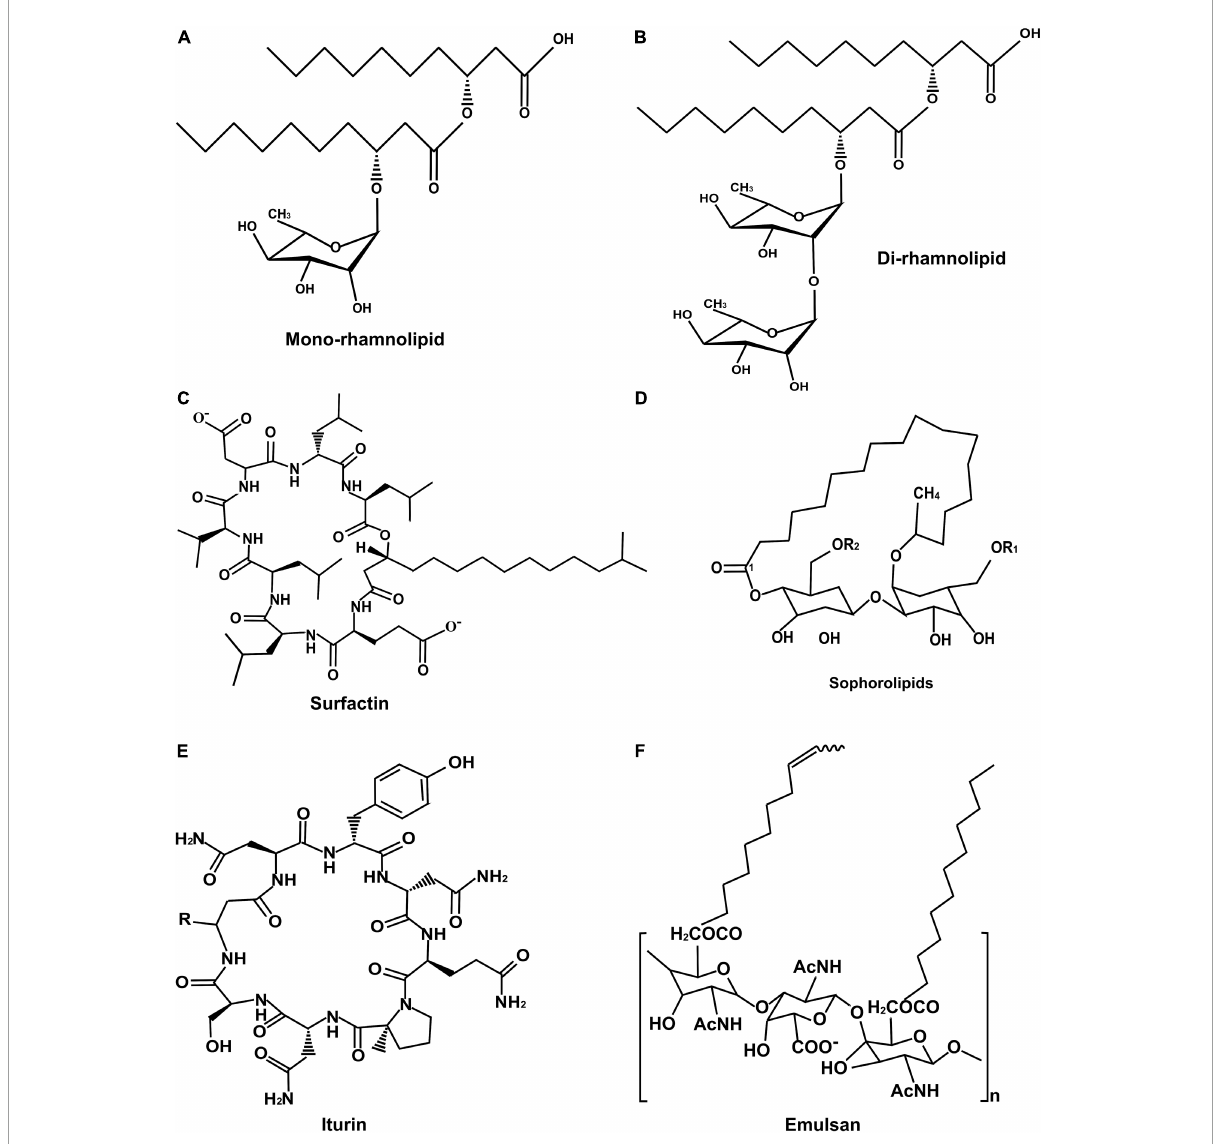
FIGURE2 Structure of important biosurfactants: (A) Mono-rhamnolipid, (B) Di-rhamnolipid, (C) Surfactin, (D) Sophorolipid, (E) Iturin, and (F) Emulsan.